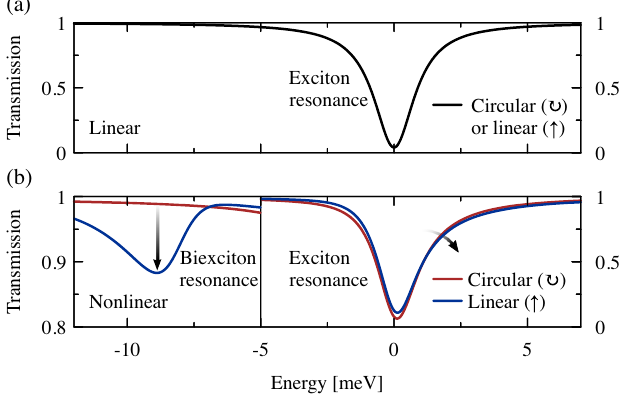
FIG. 2. (a) Linear (pulse area Θ → 0 ) and (b) nonlinear (pulse area Θ ¼ 0 . 1 π ) transmission spectra near the exciton resonance P for circularly ( ↻ ) and linearly ( ↑ ) polarized excitation with (cid:3) 40 fs pulses (intensity FWHM) for a monolayer of MoS 2 at 5 K. ϵ The laser pump energy ℏ ω is resonant to the exciton p ¼ x; (cid:3) resonance energy ϵ x; (cid:3)